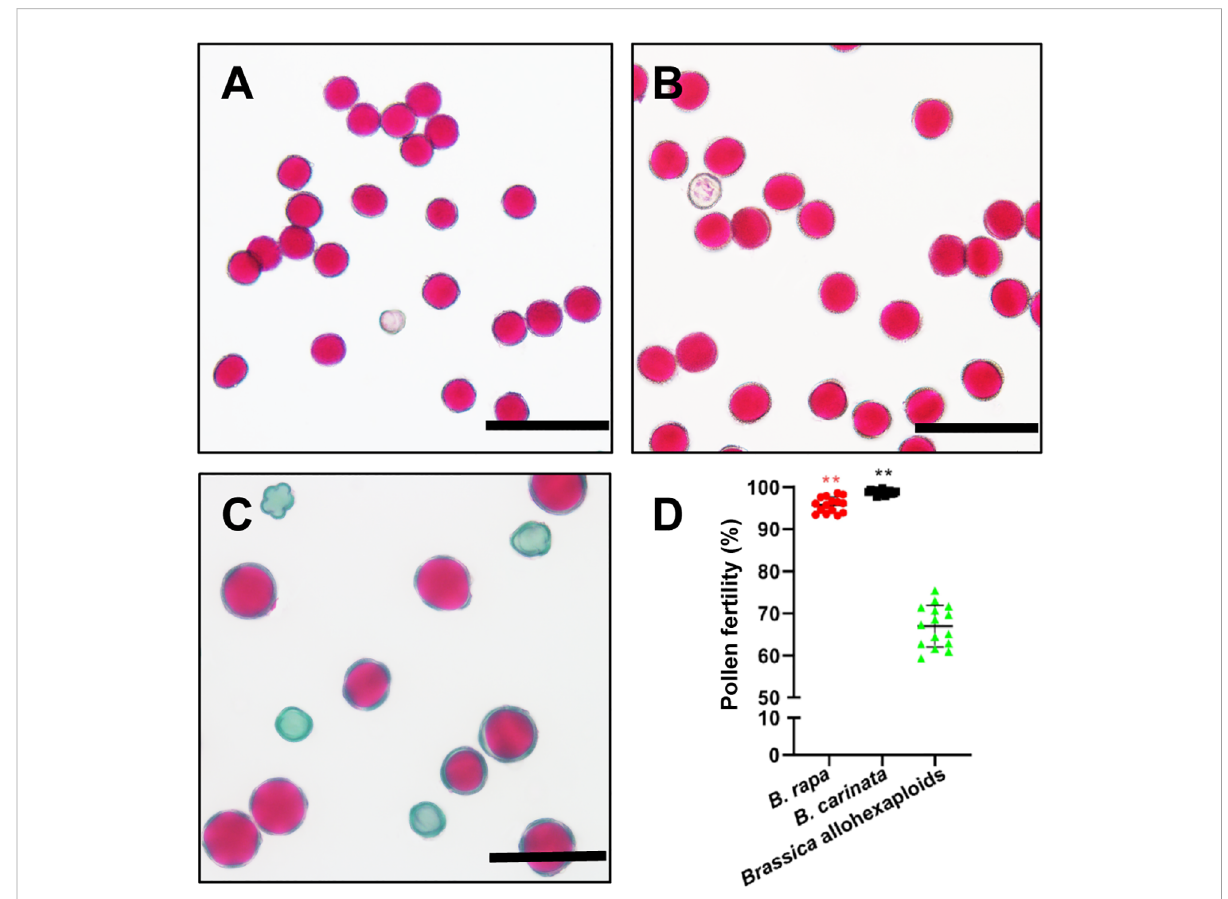
FIGURE 1 Pollen fertility and morphology observation analyses of B. rapa , B. carinata and Brassica allohexaploids. (A – C) Pollen fertility of B. rapa , B. carinata and Brassica allohexaploids determined by Alexander staining. (D) Statistical analysis of pollen fertility determined by Alexander staining. ** indicates a signi fi cant difference at P ≤ 0.01 analyzed by Analysis of Variance